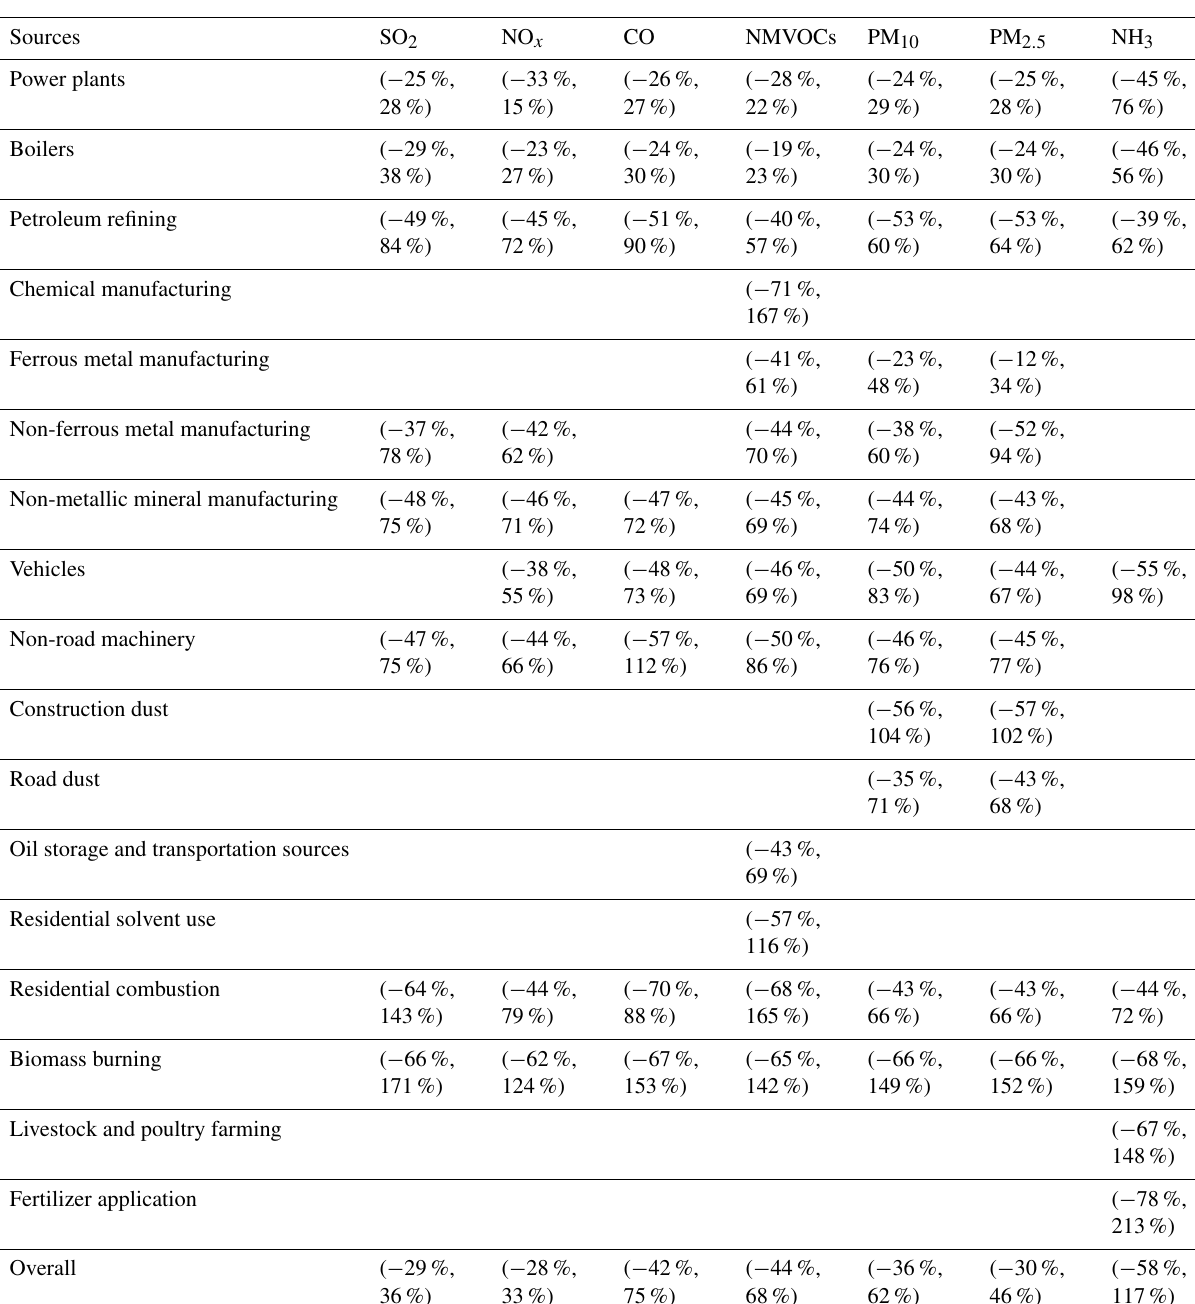
Table 3. Uncertainty assessment for the major emission sources in the YRD